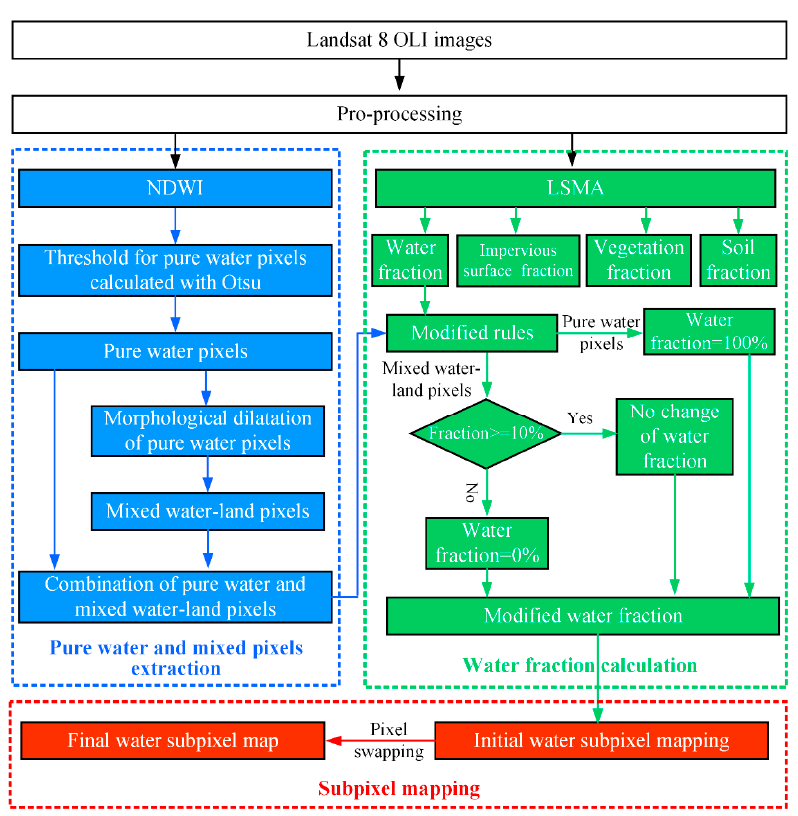
Figure 2. Flow chart of the proposed subpixel water mapping method (SWMM).